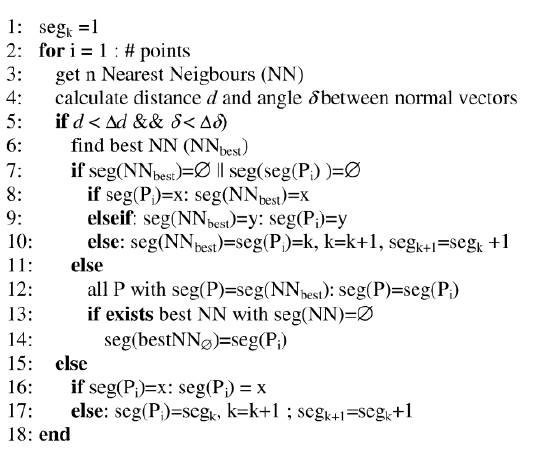
Figure 3: Proposed algorithm for façade plane